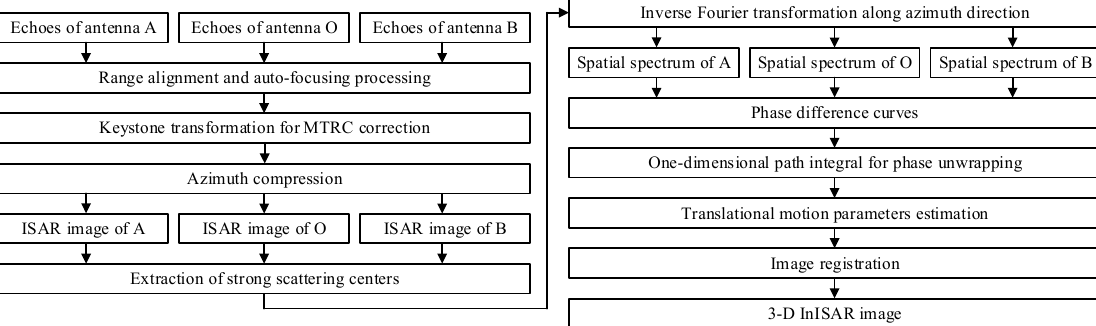
Figure 2. The flowchart of InISAR imaging based on the strong scattering centers fusion (SSCF) technique.